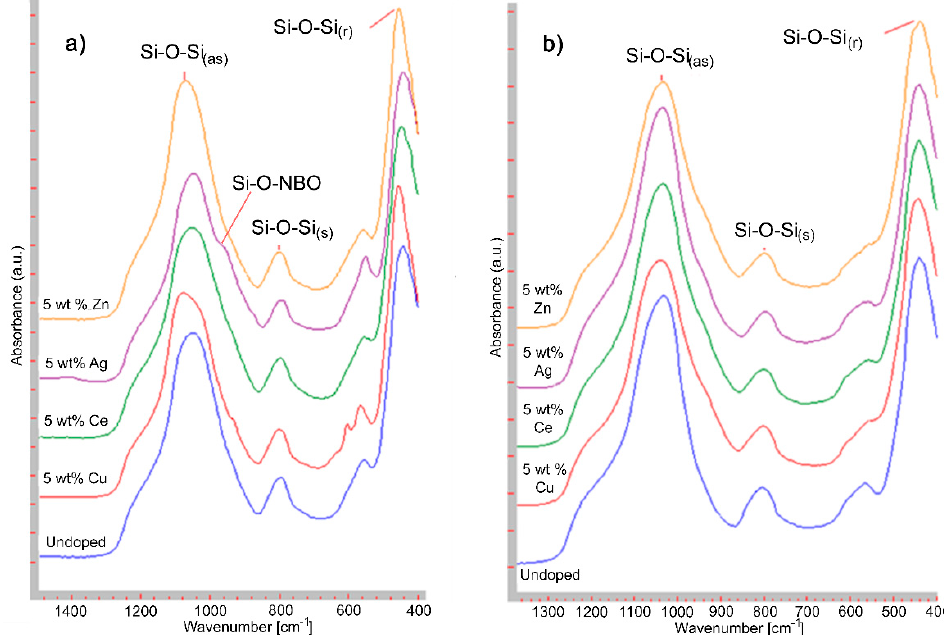
Figure 5. Fourier transform infrared spectroscopy (FTIR) spectra of: ( a ) Non-ordered mesoporous glasses; ( b ) ordered mesoporous glasses. (r) Shows rocking, (as) is asymmetric and (s) is symmetric. The main vibrational bands and associated approximate peak wavenumbers can be seen in Table 3. Table 3. Vibrational band assignments and approximate peak band wavenumbers for non-ordered and ordered mesoporous undoped and doped glasses, where ns = not seen.